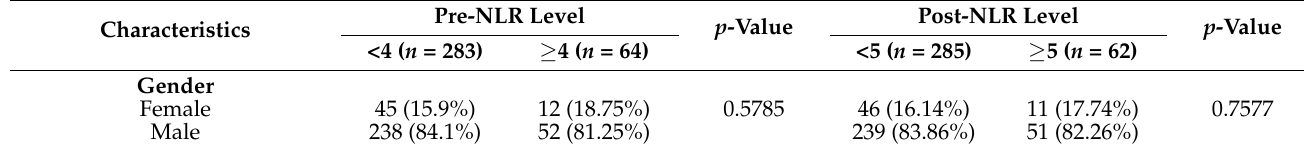
Table 2. Patient characteristics by pre-NLR and